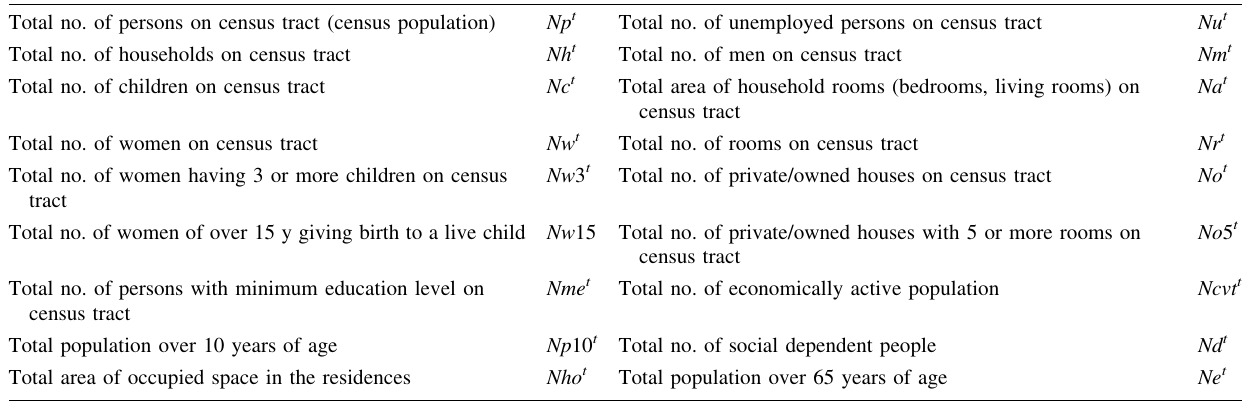
Table 1 Census data variables selected for inclusion in vulnerability index. Source Armas¸ and Gavris¸ (2013) Total no. of persons on census tract (census population)